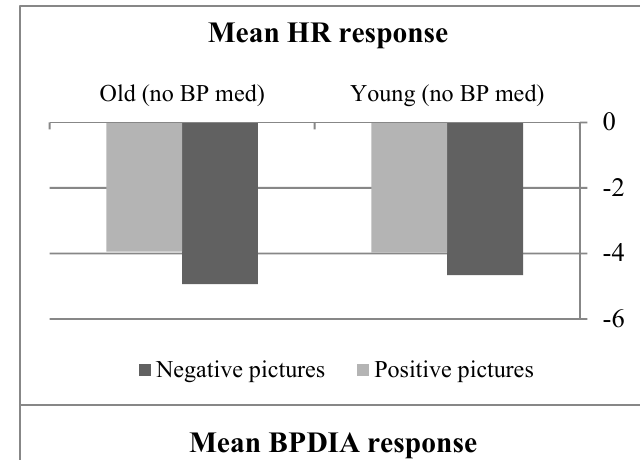
Figure A1. Mean heart rate (HR), mean diastolic blood pressure (BPDIA), and mean systolic blood pressure (BPSYS) during negative and positive picture presentations as compared to the baseline, for older adults (N = 20) and young adults (N = 17).